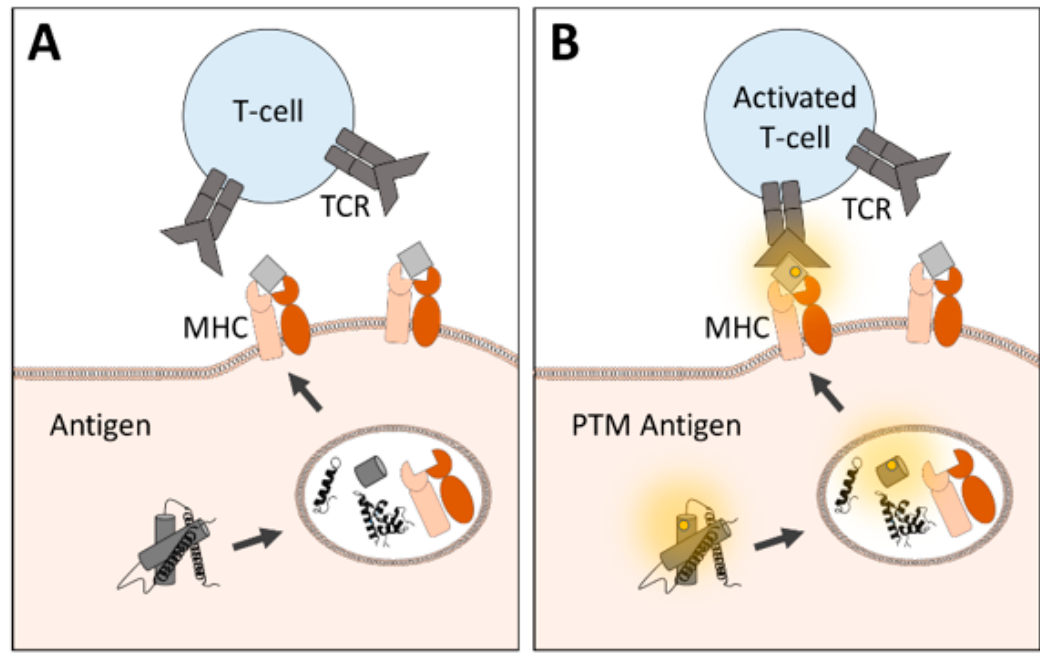
Figure 2. Immunogenicity of native and modified peptides is presented via major histocompatibility complex (MHC). T cells express antigen-specific receptors (TCR) with a specific binding site for MHC-presented peptides. While ( A ) native structures may not induce T cell activation, ( B ) post-translational modified peptides enable an altered binding affinity leading to an immune response.